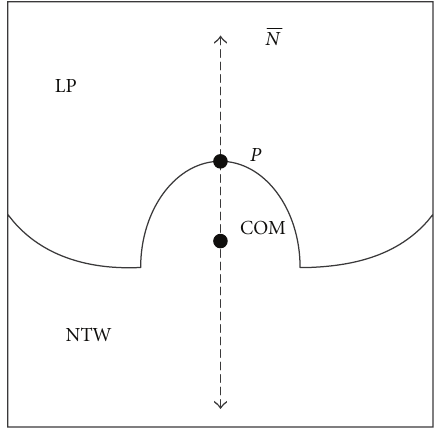
Figure 6: Procedure for finding nodule surface point. Beginning from the center of mass (COM), the algorithm searches for a surface point ( P ) in the direction of the average surface normal ( N